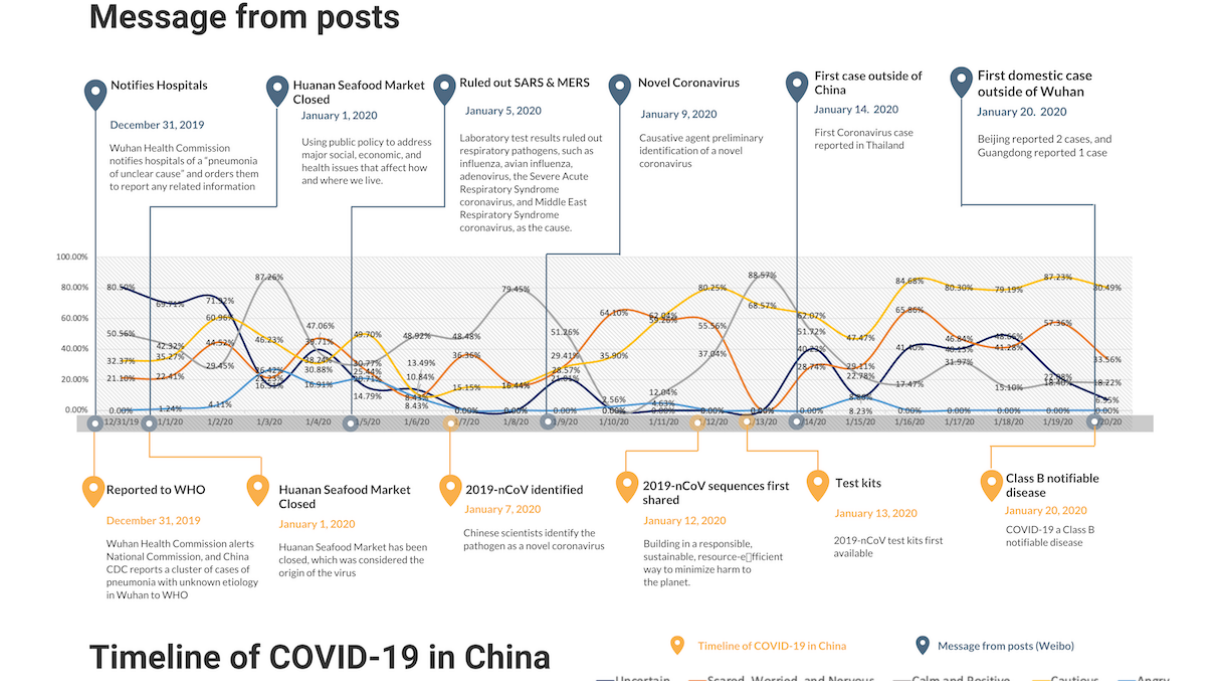
Figure 2. Percentage and classification of public sentiment posts and timeline of events. CDC: Center for Disease Control and Prevention; MERS: Middle East respiratory syndrome; SARS: severe acute respiratory syndrome; WHO: World Health Organization; 2019-nCoV: novel